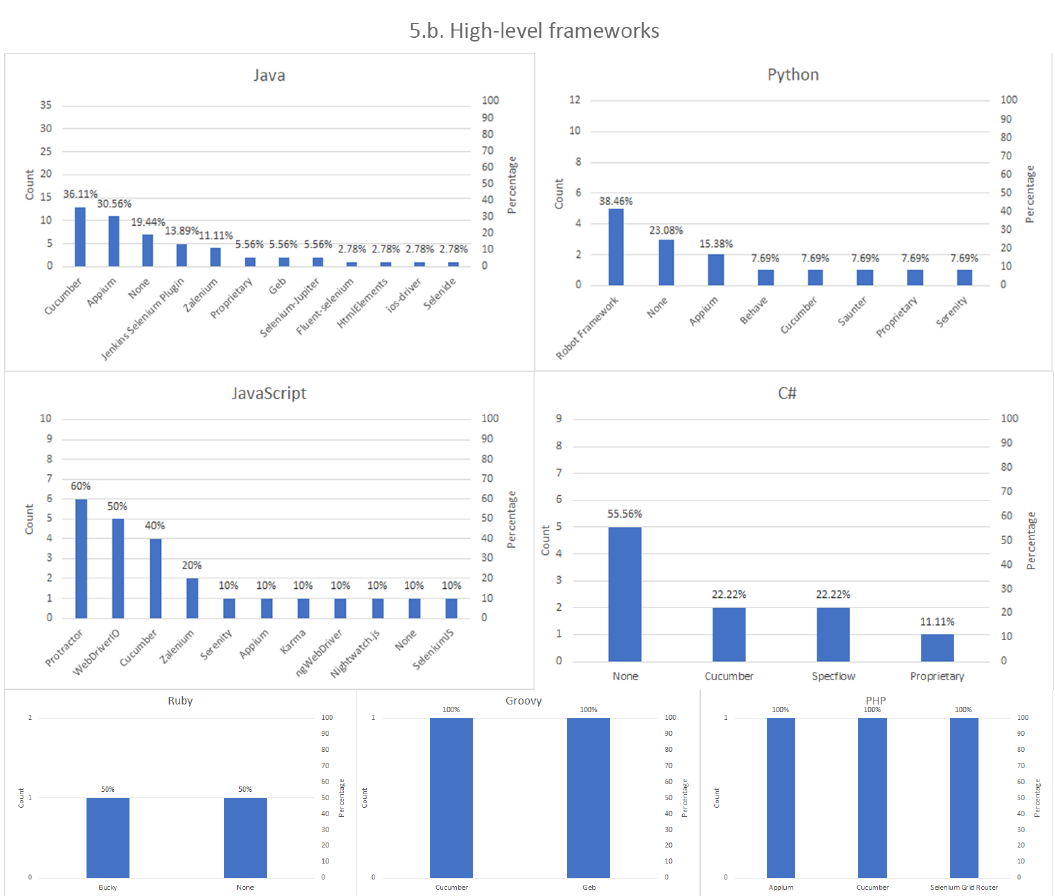
Figure 12. High-level testing frameworks based on